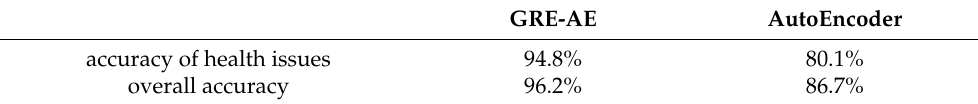
Table 2. Comparison of monitoring